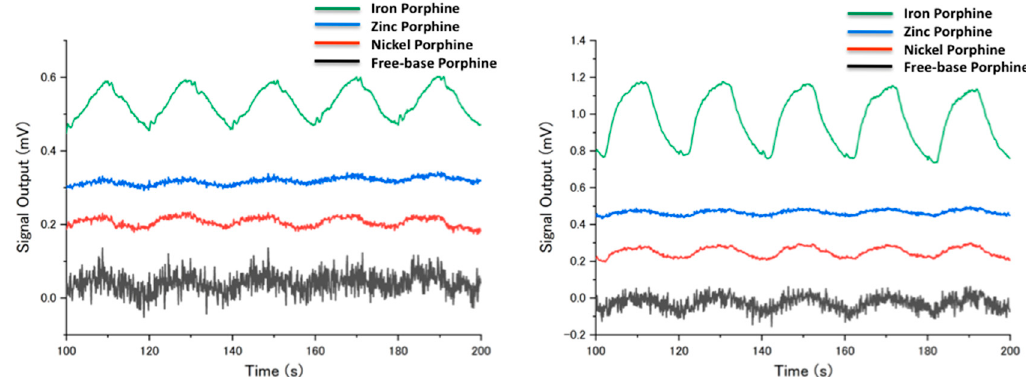
Figure 6. Sensitivity at 25 °C and 10% in partial vapor pressure at different humidity.